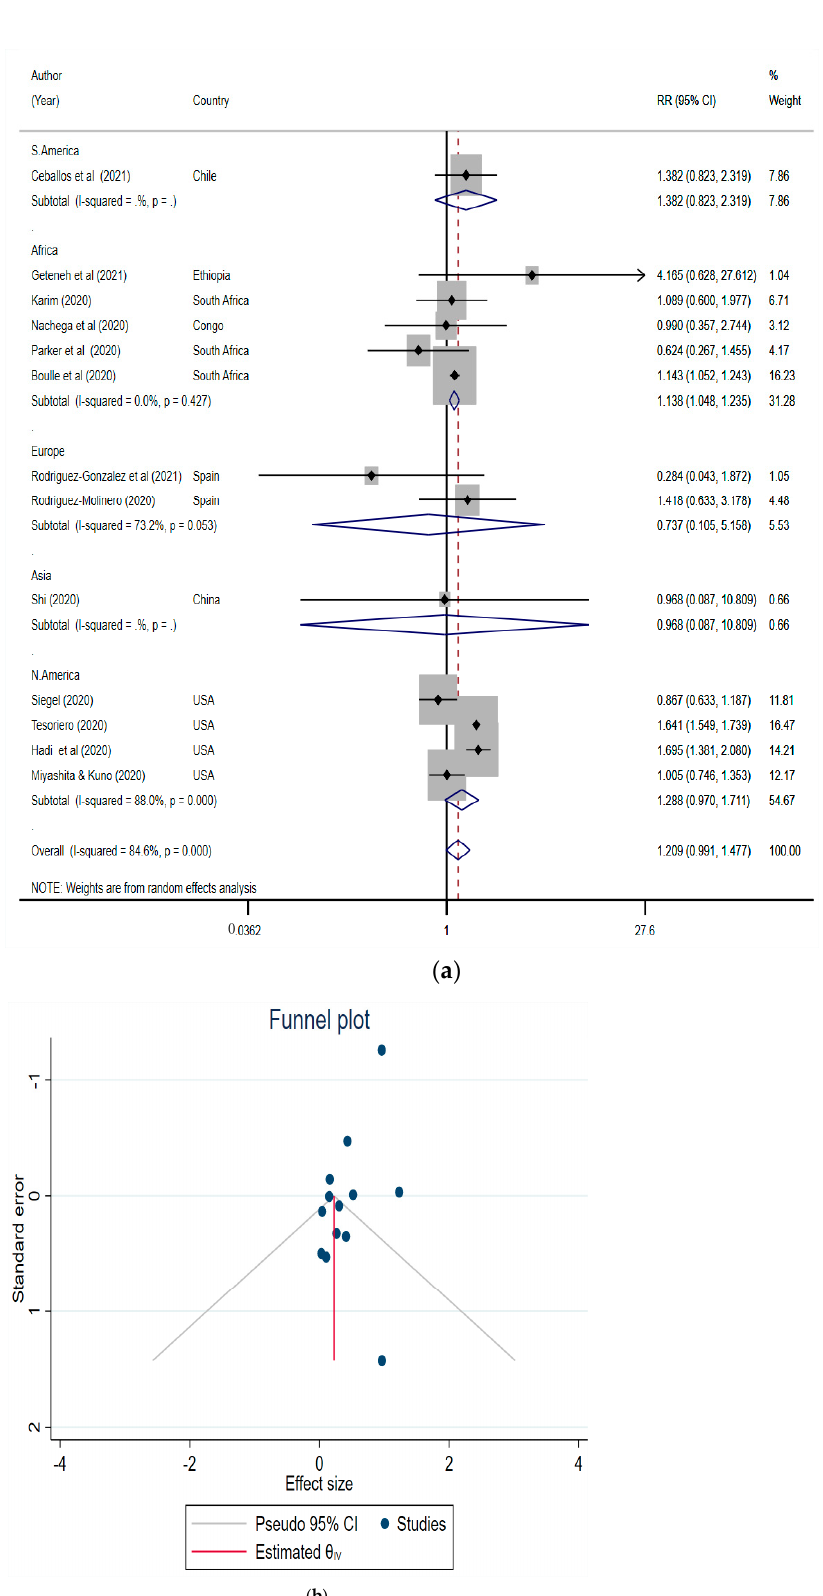
Figure 3. ( a ) Forest plot of studies pooled for the risk of severe COVID-19 in PLWH. The red dotted line represents the overall effect size/risk ratio. The lateral edges of the bluediamonds represent the limits of the 95% confidence intervals (RR: risk ratio; CI: confidence interval). ( b ) Funnel plot of studies pooled for the risk of severe COVID-19 in PLWH (CI: confidence interval).